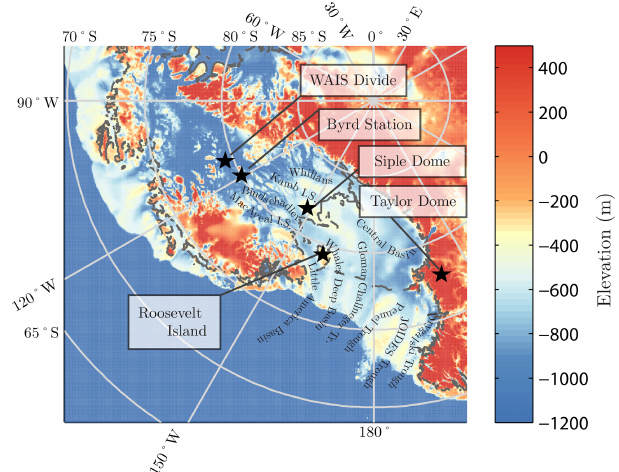
Figure 1. Map of bedrock elevation in the Ross Sea Sector of Antarctica (referenced to WGS84 datum) (Fretwell et al., 2013). Gray dashed lines indicate ice sheet grounding lines and ice mar- gins. Locations of the RICE (Roosevelt Island), Siple Dome, Byrd Station, WAIS Divide, and Taylor Dome ice cores are marked with black stars.